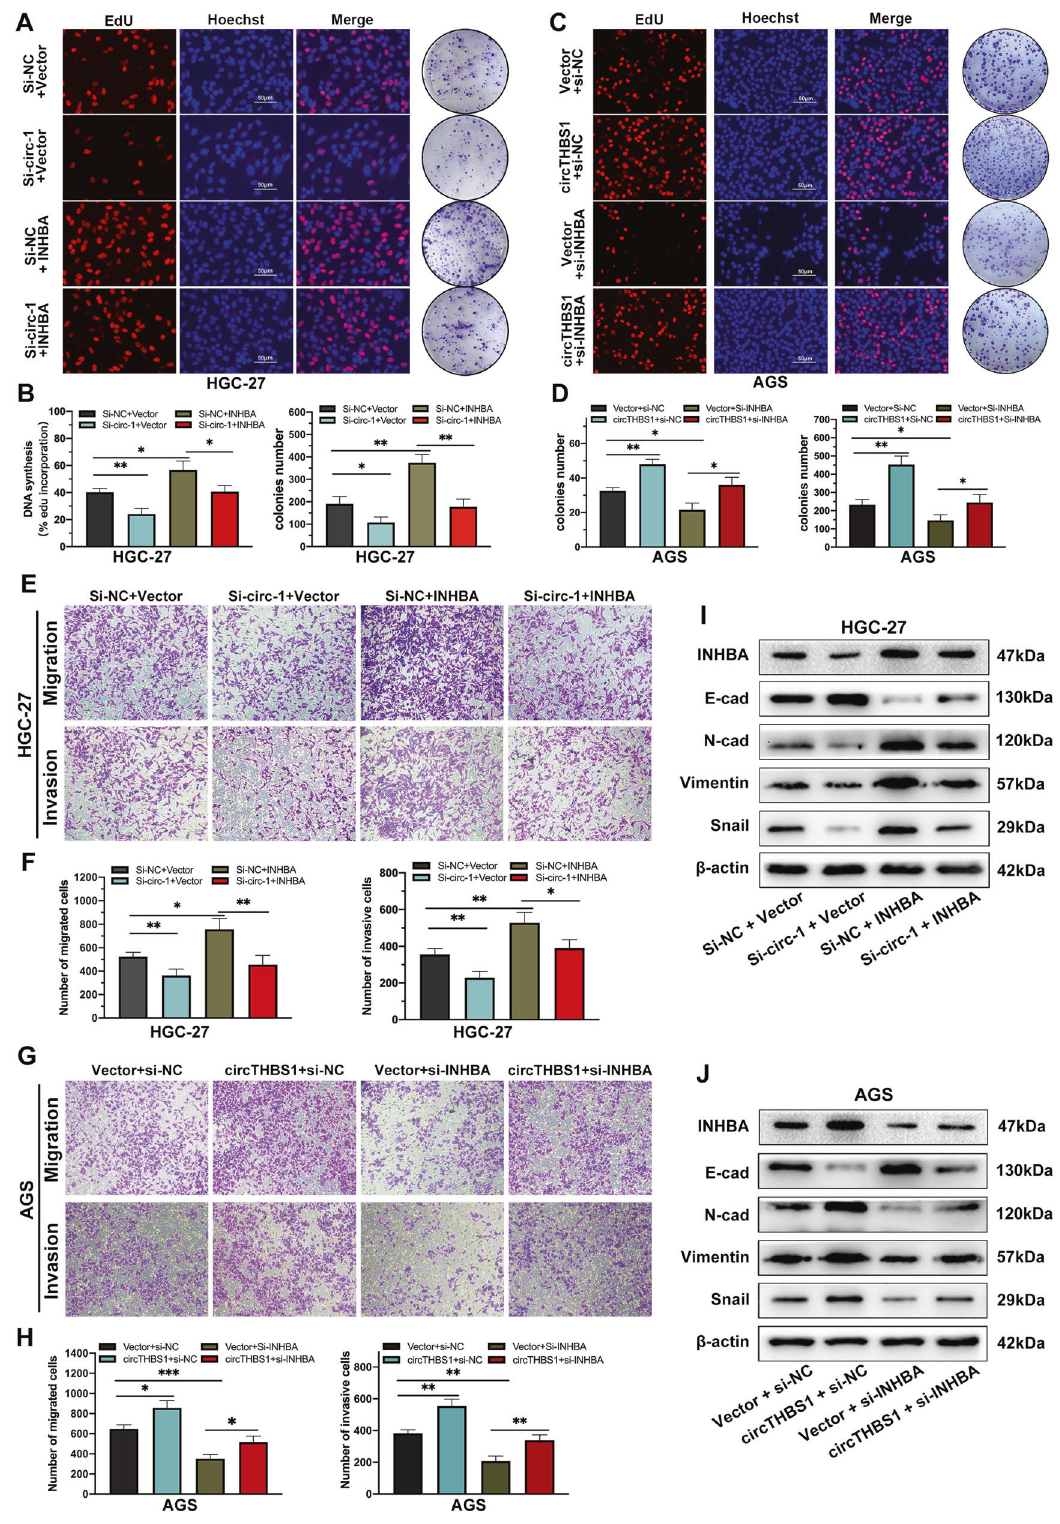
Fig. 7 CircTHBS1 exerts biological functions by targeting INHBA. A, B EdU assays and colony formation assays revealed that co-transfection of INHBA overexpression plasmid and si-circTHBS1 in HGC-27 cells counteracted the suppressing effects caused by circTHBS1 knockdown. C, D EdU assays and colony formation assays showed that co-transfection of si-INHBA in circTHBS1 overexpression AGS cells counteracted the facilitative effect of circTHBS1 overexpression. E, F Transwell assays in HGC-27 cells showed that the up-regulation of INHBA restored the suppressive effect of circTHBS1 knockdown on cell migration and invasion. G, H The promotive effect on cell migration and invasion caused by circTHBS1 overexpression was weaken by INHBA knockdown in AGS cells. I, J Overexpression of INHBA reversed the effect of circTHBS1 knockdown on expression of key proteins involved in EMT. Quantitative data presented as the mean ± SD. * P < 0.05, ** P < 0.01, *** P < 0.001 (Student ’ s t -test). Cell Death and Disease (2022)